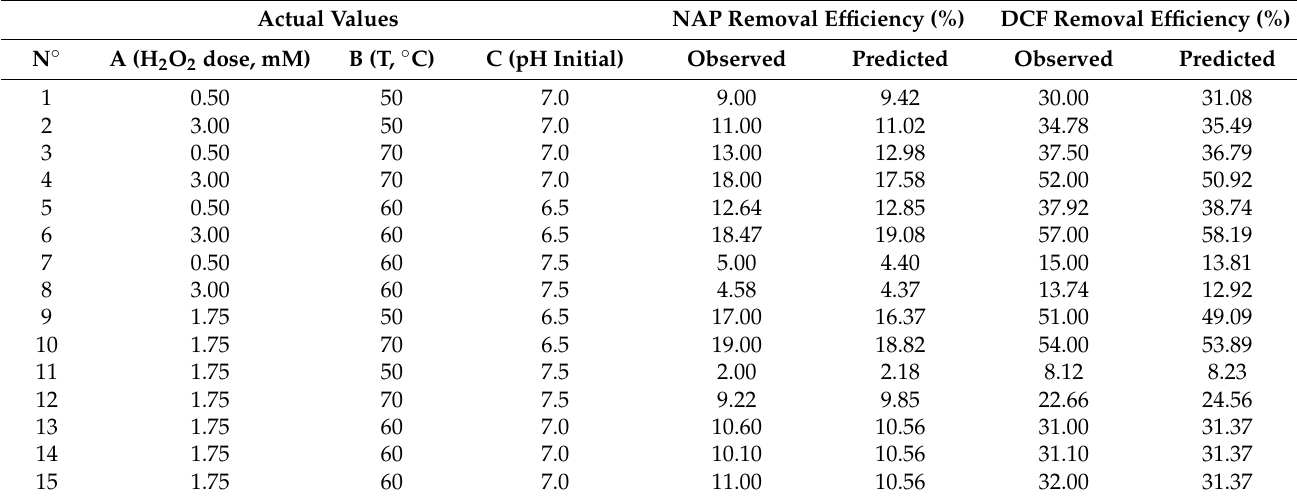
Table 3. Experimental design matrix of the degradation of NAP and DCF by CWPO.